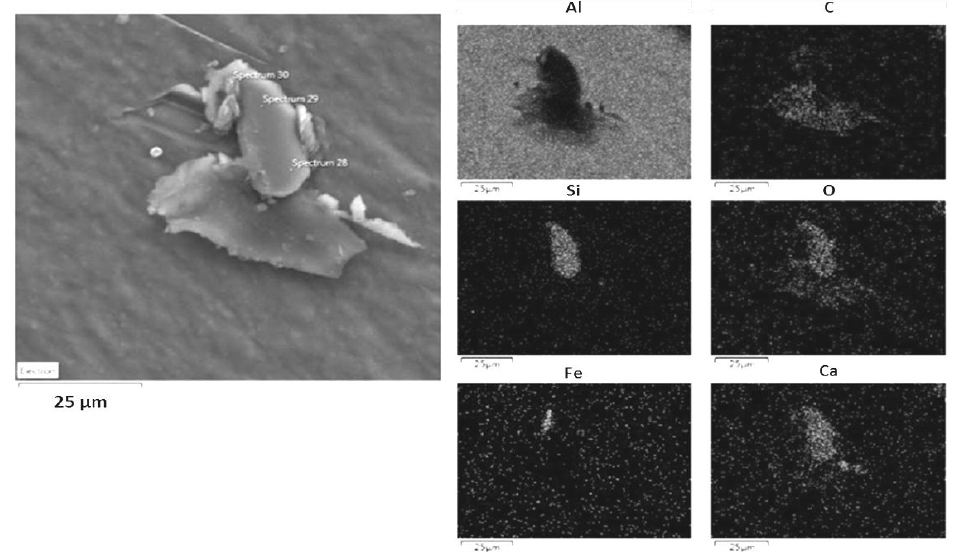
Figure 7. SEM analysis of the particles aggregates collected on 11 February 2015, 20 m from the drone launch site. The chemical mapping by energy-dispersive spectroscopy (EDS) of major elements (Al, C, Si, O, Fe, and Ca) is shown in the right pictures.